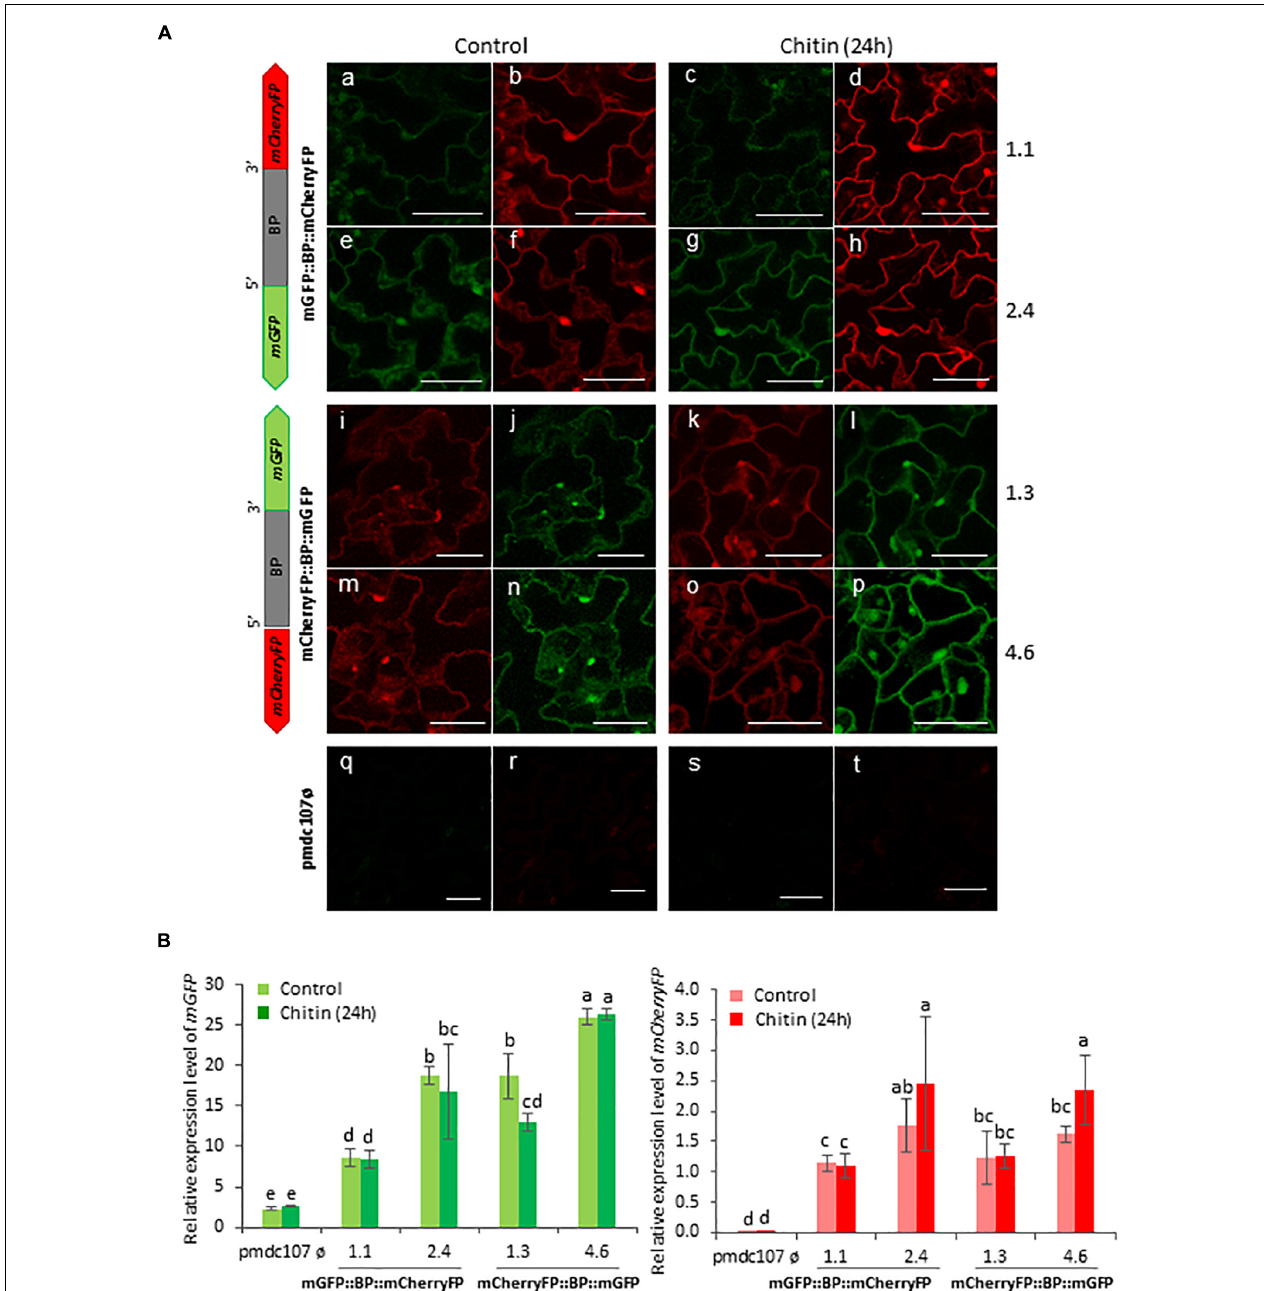
FIGURE 8 | Schematic representation of fusion-constructs and expression assays in stably transformed Arabidopsis plants in response to Chitin treatment. (A) Scheme of mCherryFP and mGFP genes driven by the bidirectional promoter (BD) and confocal stacks spanning Arabidopsis epidermal cells of transformed plants after 1 h of Chitin treatment. Projections are from mCherryFP (b,d,f,h,i,k,m,o,r,t) and mGFP (a,c,e,g,j,l,n,p,q,s) . Bars are 50 µ m. (B) Quantitative analyses of mGFP and mCherryFP expression by RT-qPCR in Arabidopsis transformed plants after 1 h of chitin treatment. Bars in green and red colors correspond to mGFP and mCherryFP gene expression, respectively. Data are ± SE of three biological replicates. Differential letters indicate statistical differences ( P < 0.05 Wald χ 2 followed by LSD test). Arabidopsis selected lines for mGP::BBP::mCherryFP construct were 1.1. and 2.4, and for mCherryFP::BD::mGFP were 1.3 and 4.6. Primers used for this experiment are listed in Supplementary Table 1